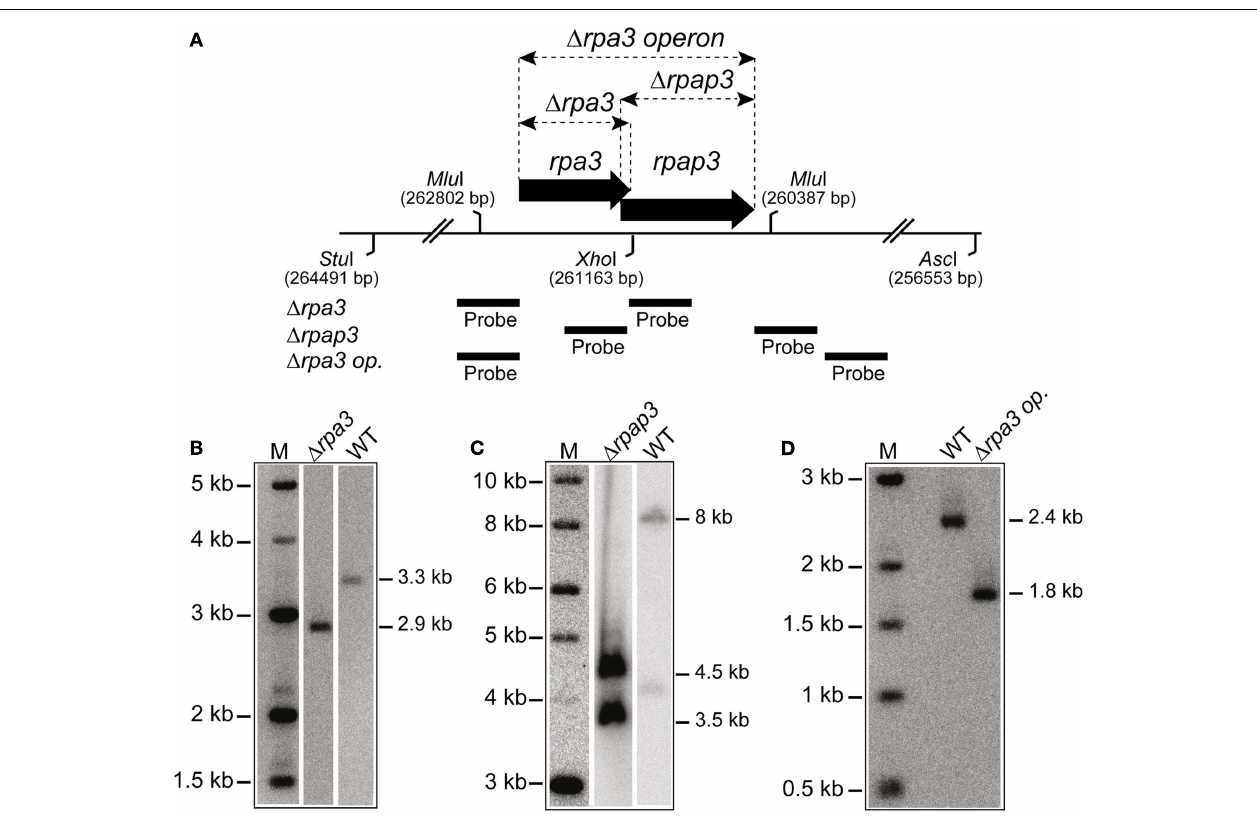
DNA cut with Asc I and Stu I, and probed with flanking regions of rpap3 , as shown in Figure 2A , to indicate deletion of the rpap3 . (D) Southern blot of genomic DNA cut with Mlu I and probed with flanking regions of rpa3 operon ( rpa3 op. ), as shown in Figure 2A , to indicate deletion of the rpa3